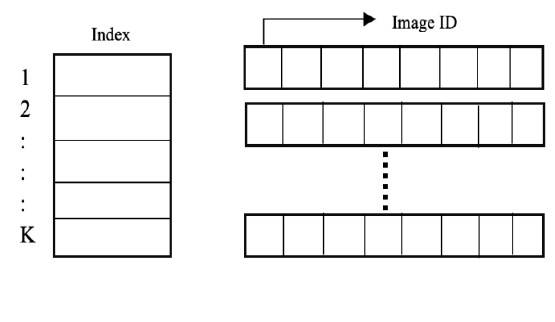
Figure 3. Indexing of